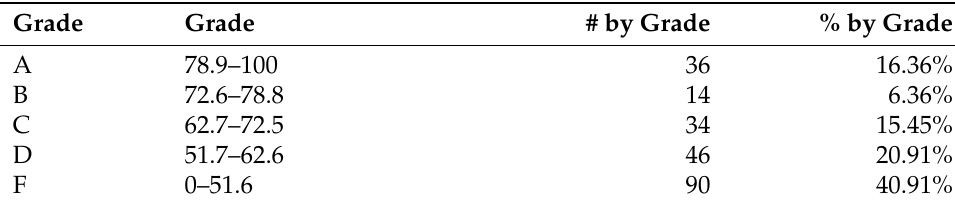
Table 2. Graded System Usability Scale